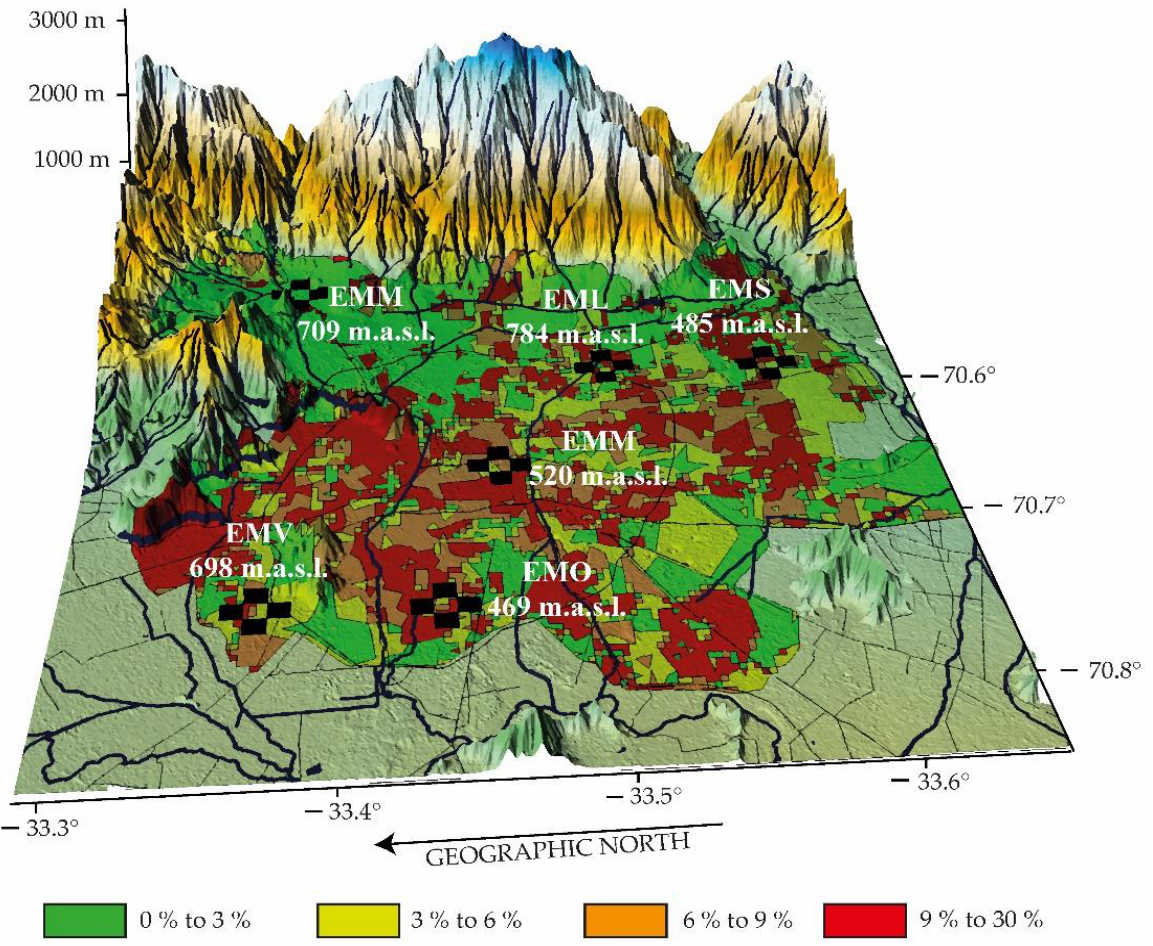
Figure 5. Geographical distribution of the monitoring stations for this study (network of black crosses) and high urban densification [37] (in color for the areas with the highest population den- sity).